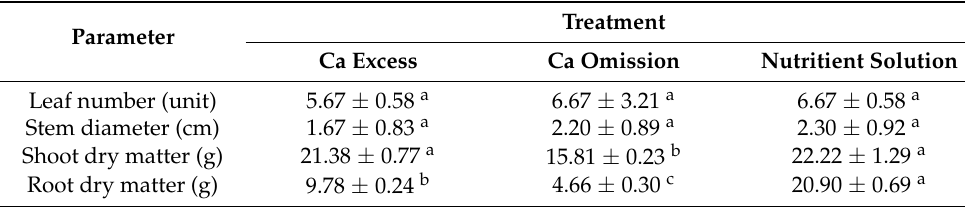
Table 2. Vegetative growth parameters of plants after 40 days of cultivation in nutrient solution with varying amounts of calcium.